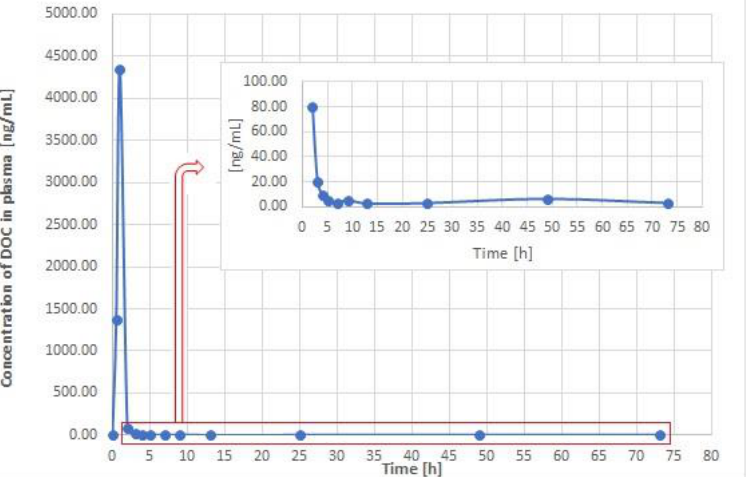
Figure 2. DOC concentration profiles in time intervals for plasma samples from a 12-year-old cardiac AS patient after a 1 h IV infusion of DOC at a dose of 45 mg (30 mg/m 2 ).